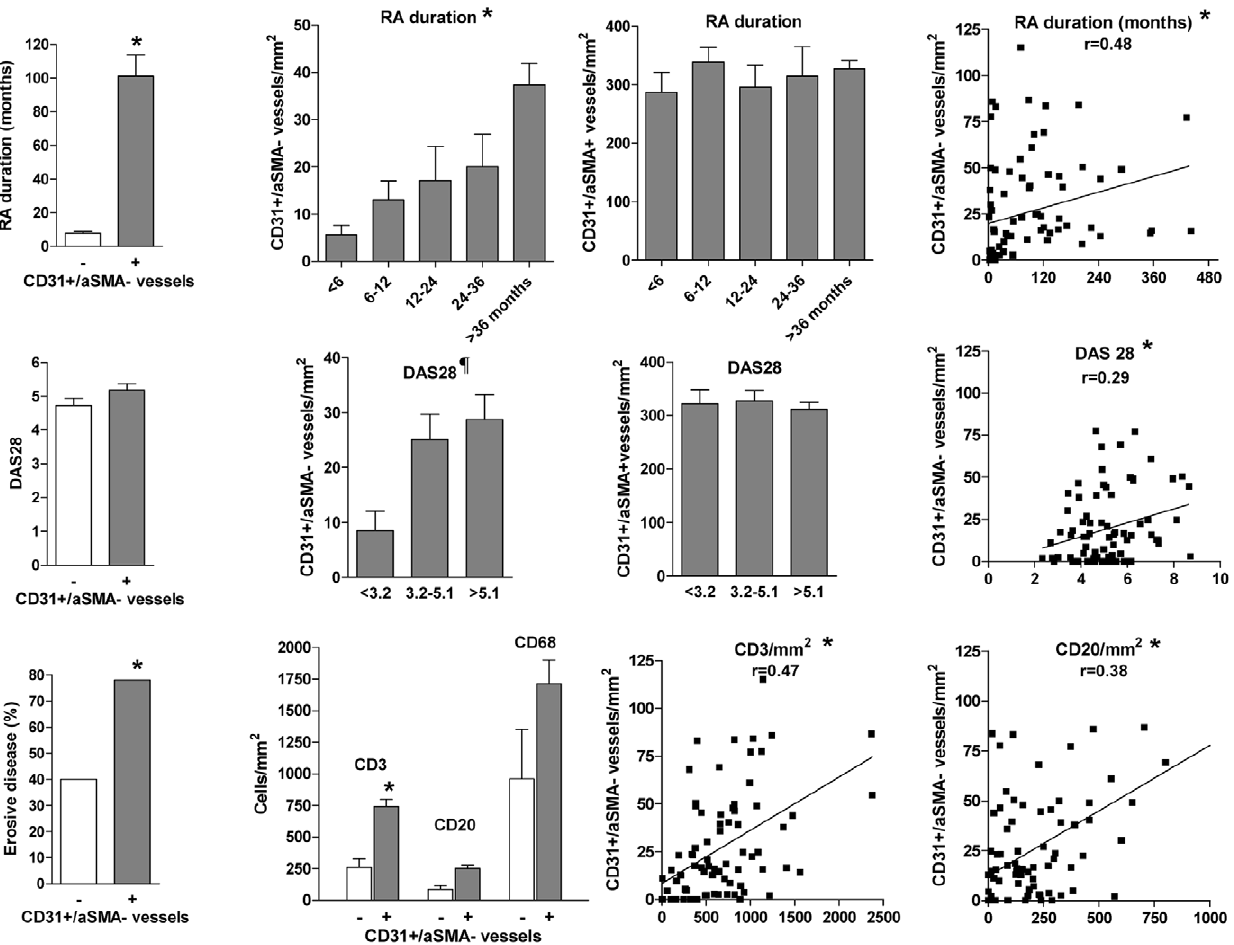
Figure 3. Clinicopathological correlations of immature blood vessels in RA synovial tissues. Disease duration, DAS28 score, erosive disease, and synovial tissue infiltration by CD3, CD20 or CD68 cells is shown in groups with ( + ) or without ( 2 ) immature vessels as indicated. Density of mature or immature vessels in patients stratified by disease duration and levels of activity (low: DAS28 , 3.2, moderate 3.2–5.1, or high . 5.1). Spearman’s correlation coefficients between immature vessels density and disease duration, DAS28, CD3 or CD20 infiltration are shown. (*) p , 0.05 (see text). " p=0.04 (Kruskall Wallys test and post hoc Dunns test (low versus moderate or high activity groups).